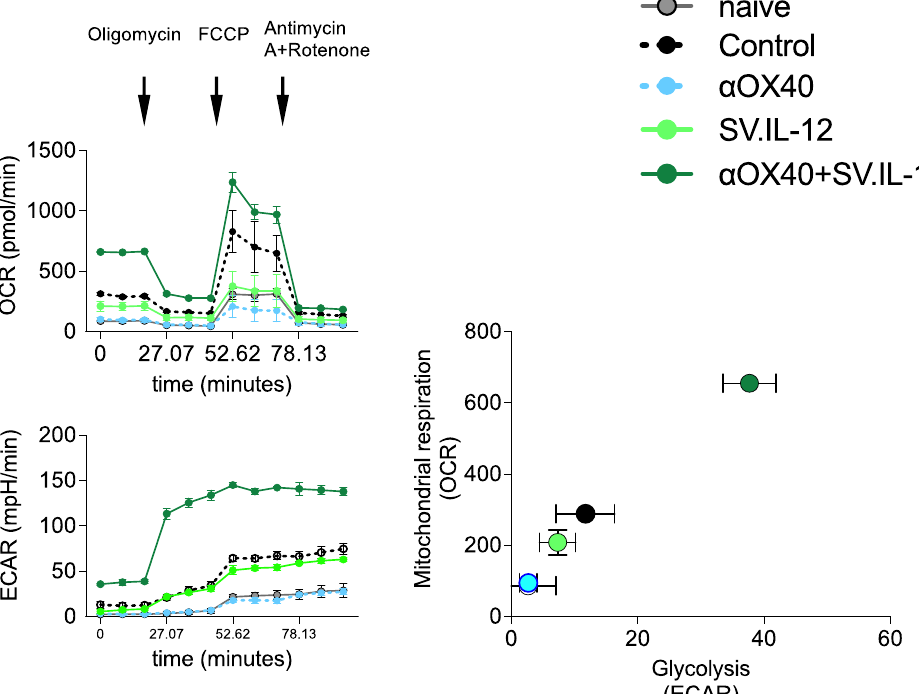
Figure 8. Metabolic impact on T cells from mice treated with combination therapies that include SV.IL-12 plus α OX40 antibody in the MOSEC model. Tumor-bearing mice were left untreated or treated with SV.IL-12 and/or α OX40. T cells were isolated from spleens on day 7 after treatment starts (day 14 from tumor implantation). ( A ) Mitochondrial respiration was assessed by measuring the median values of ( A ) oxygen consumption rates (OCRs) and ( B ) baseline extracellular acidifi- cation rates (ECARs) in T cells of indicated groups using an extracellular flux analyzer on day 7 of treatments. Oligomycin, FCCP, antimycin A, and rotenone were injected as indicated to identify energetic mitochondrial phenotypes. ( C ) Energy profile (OCRs versus ECARs) of T cells from naive or MOSEC.Fluc.p11 tumor-bearing mice treated with SV.IL-12 and/or α OX40. Error bars indicate SEM. Note that the α OX40 and naive graph points are super-imposed. Results are representatives of at least two independent experiments.